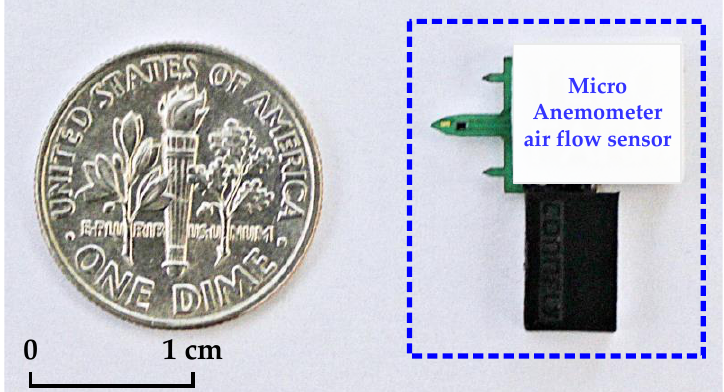
Figure 9. Photograph of manufactured micro anemometer air flow sensor.